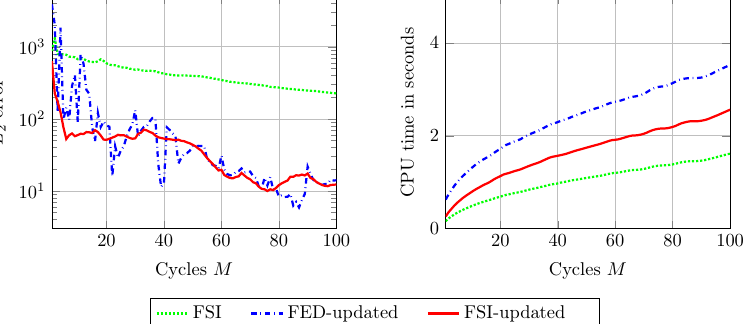
Figure A4. Results of the two-dimensional GES experiment without source: comparison of the computed L 2 -error ( left ) and the corresponding CPU time ( right ) between FSI, FED-updated and FSI-updated for a different number of cycles M at t F = 2.609 10 6 for h = 0.04. The reference × solution is computed with the EE method. To ensure numerical stability within the FED method we apply a Leja-ordering with κ = 7, for more details see [17]. Inner updates significantly improve the performance of both schemes; however, FED-updated may lead to highly unstable intermediate solutions and therefore also affects the final numerical solution, especially if a small number of cycles M is used. Contrary, FSI-updated is absolutely stable and causes lower computational costs than FED-updated.